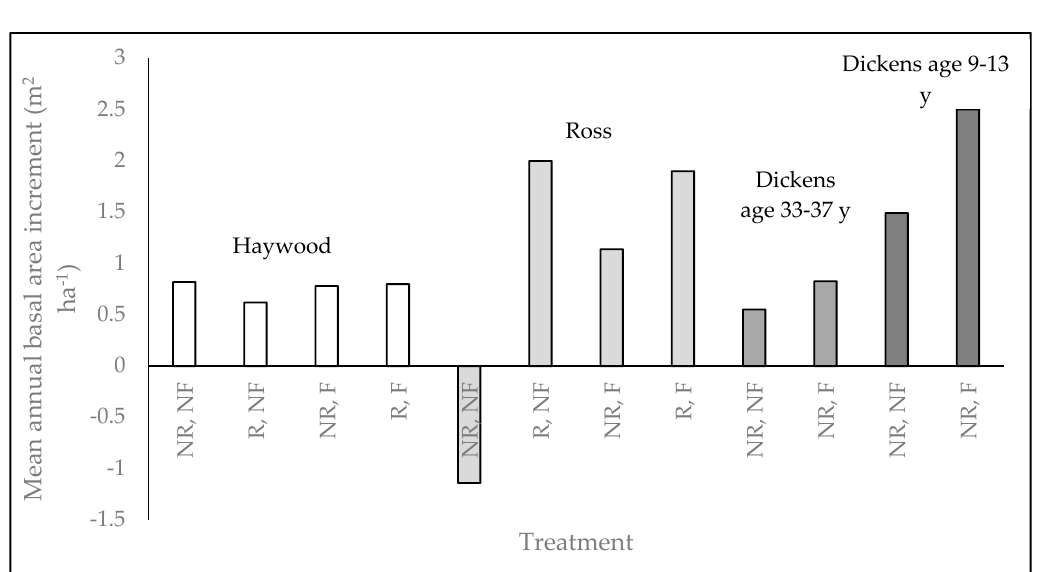
Figure 4. Longleaf pine (stand age 34–39) diameter at 137 cm above groundline (dbh) increment by treatment 0 to 3 years after treatment (YAT), 3 to 5 YAT and over the entire five-year study period [15].